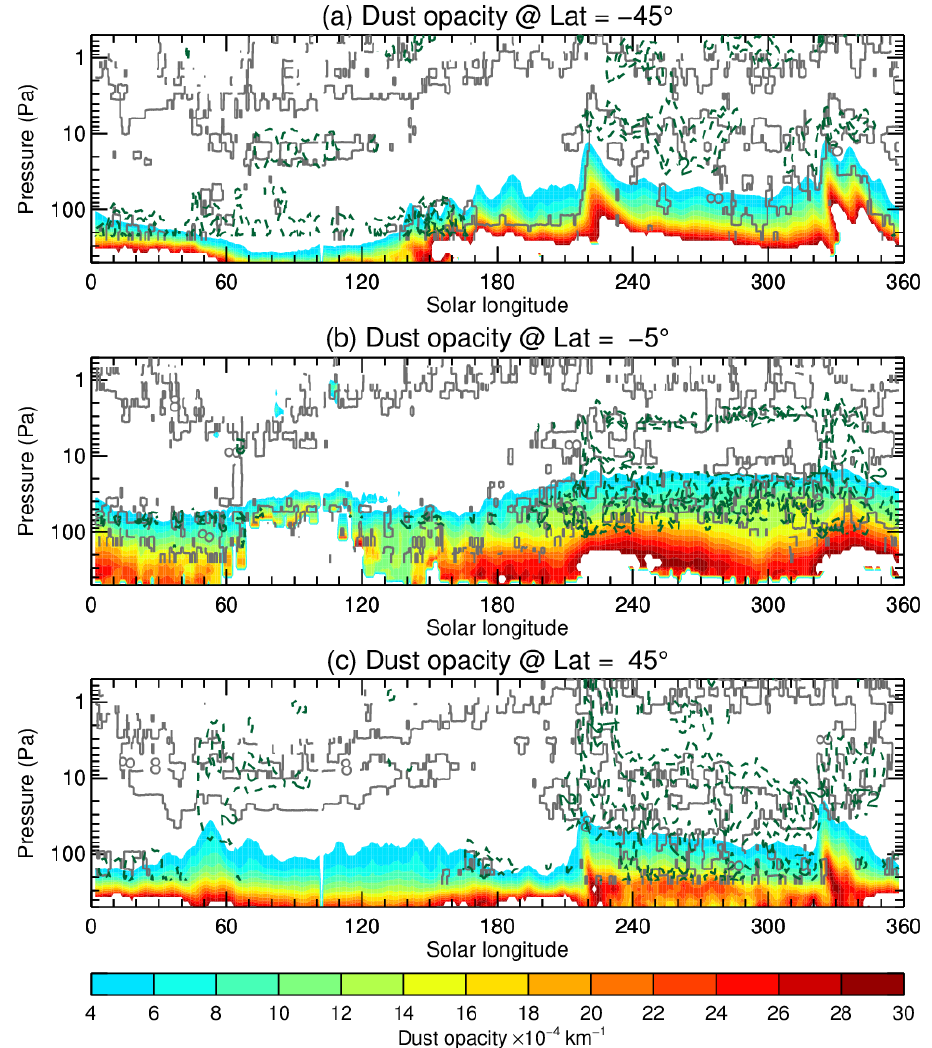
Figure 13. Seasonal variations of the zonal mean dust opacity at ( a ) 45°S, ( b ) 5°S, and ( c ) 45°N. The black contours indicate a phase difference of 8 h, as shown in Figure 10. The green dashed contours indicate a temperature DW1 amplitude that is less than 3 K. The three regional dust storms of MY 33 and their approximate duration periods [36] are, respectively: A storm, Ls = 218°–236°; B storm, Ls = 250°–285°; and C storm, Ls = 325°–345°.